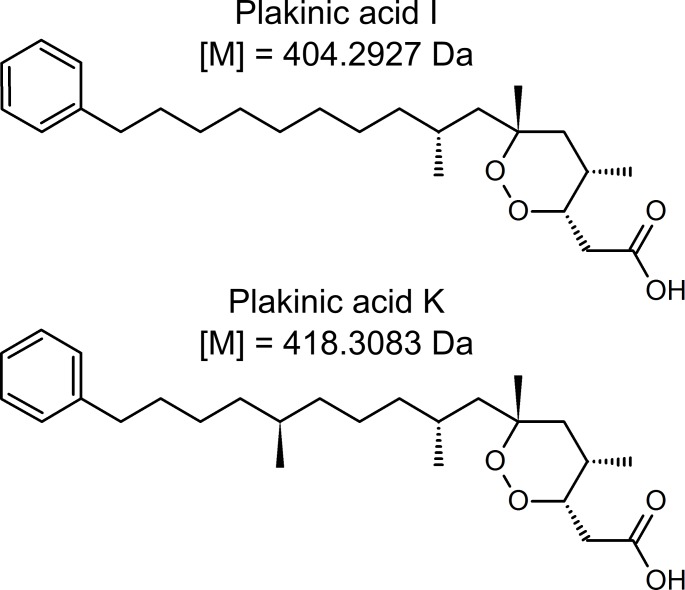
Chemical structures of plakinic acids I (C25H40O4) and K (C26H42O4) [38,39].The exact monoisotopic masses for these metabolites are consistent with the neutralized measured masses of Main Compounds 1 ([M] = 404.2904 Da, -5.7 ppm) and 2 ([M] = 418.3056 Da, -6.5 ppm).